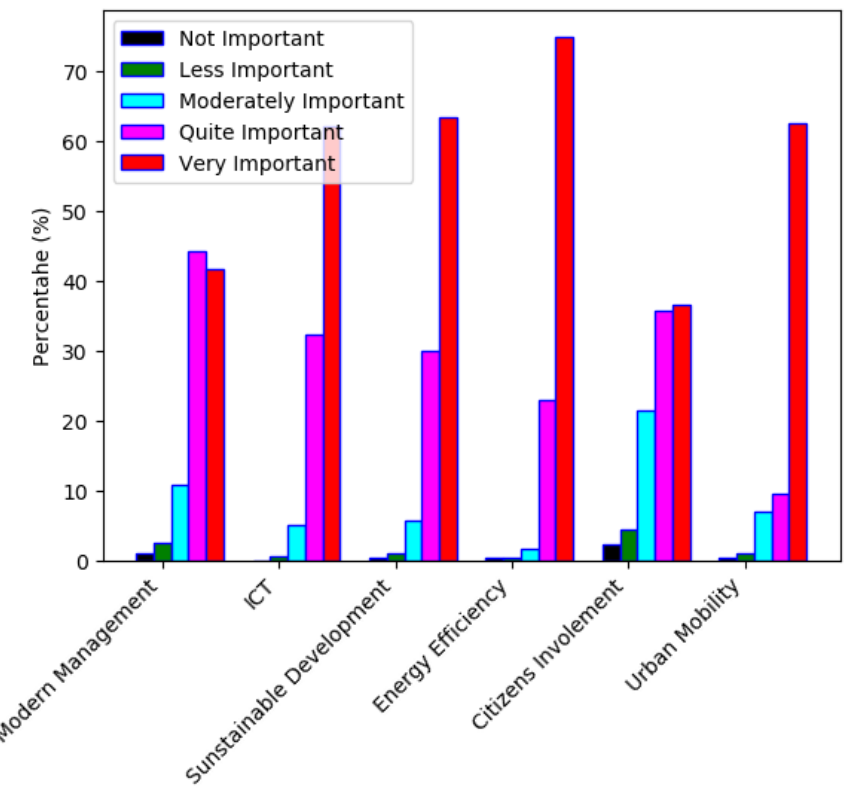
Figure 2. Importance of